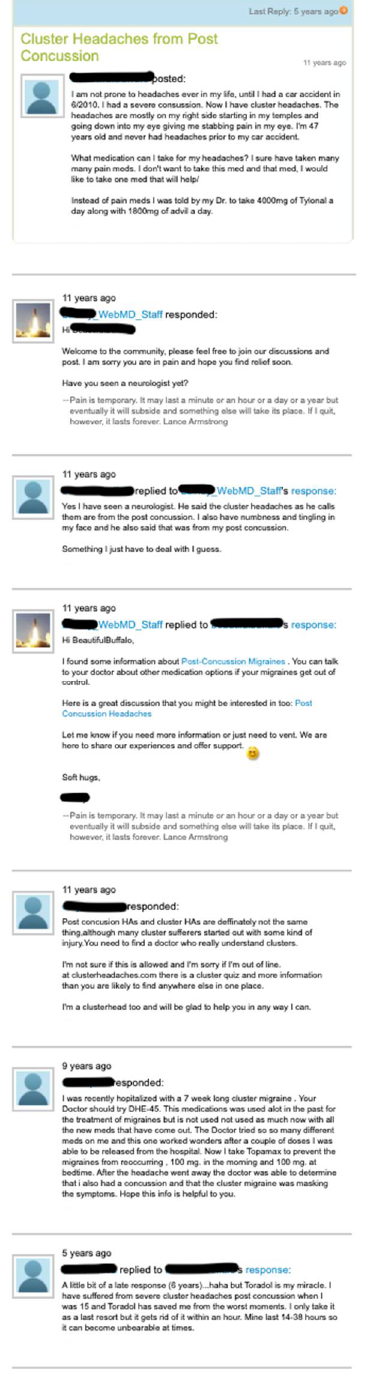
Figure A1. WebMD Communities example post.